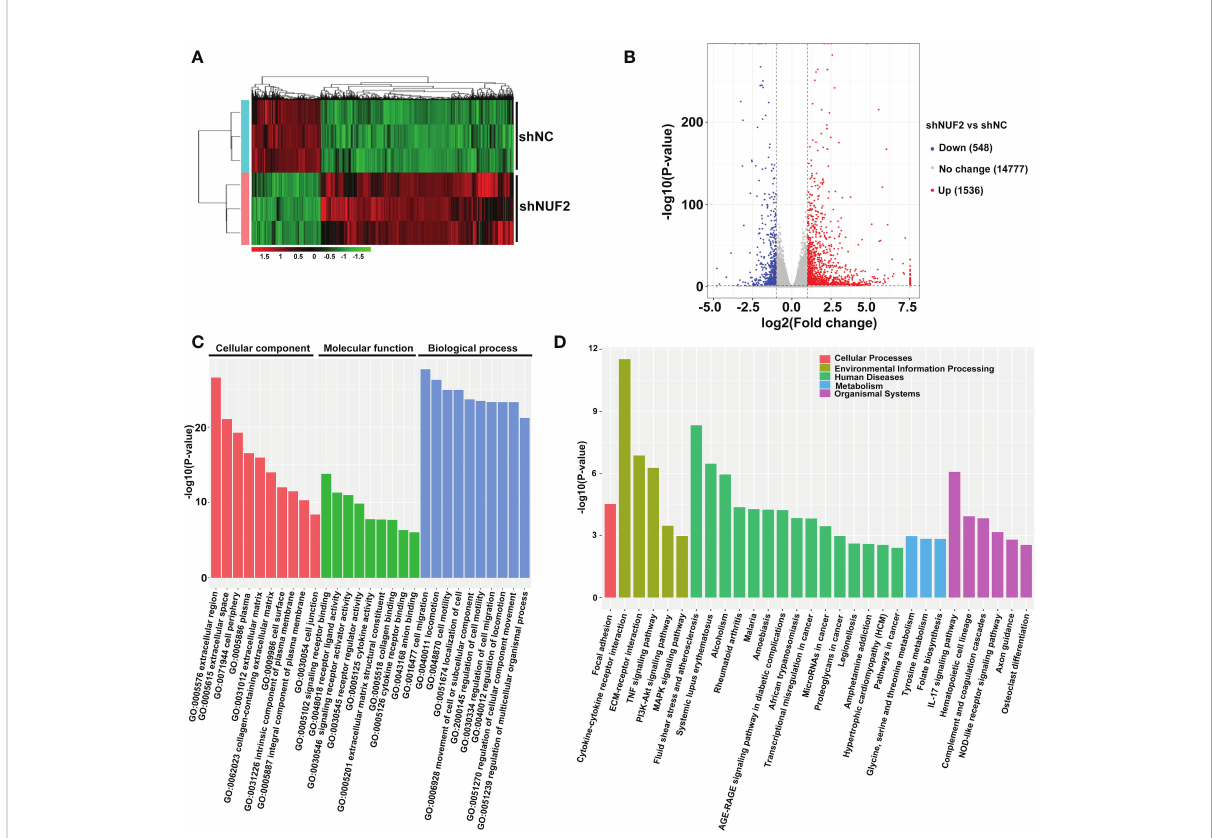
FIGURE 3 Global gene expression changes in OVCAR3 cells transfected with shNUF2 and shNC. (A, B) Heatmaps and volcano plots of the DEGs (FC, <-1- fold or >1-fold) in OVCAR3 cells infected with shNUF2 and shNC. (C, D) GO analysis and KEGG pathway enrichment of the DEGs in OVCAR3 cells infected with shNUF2 and